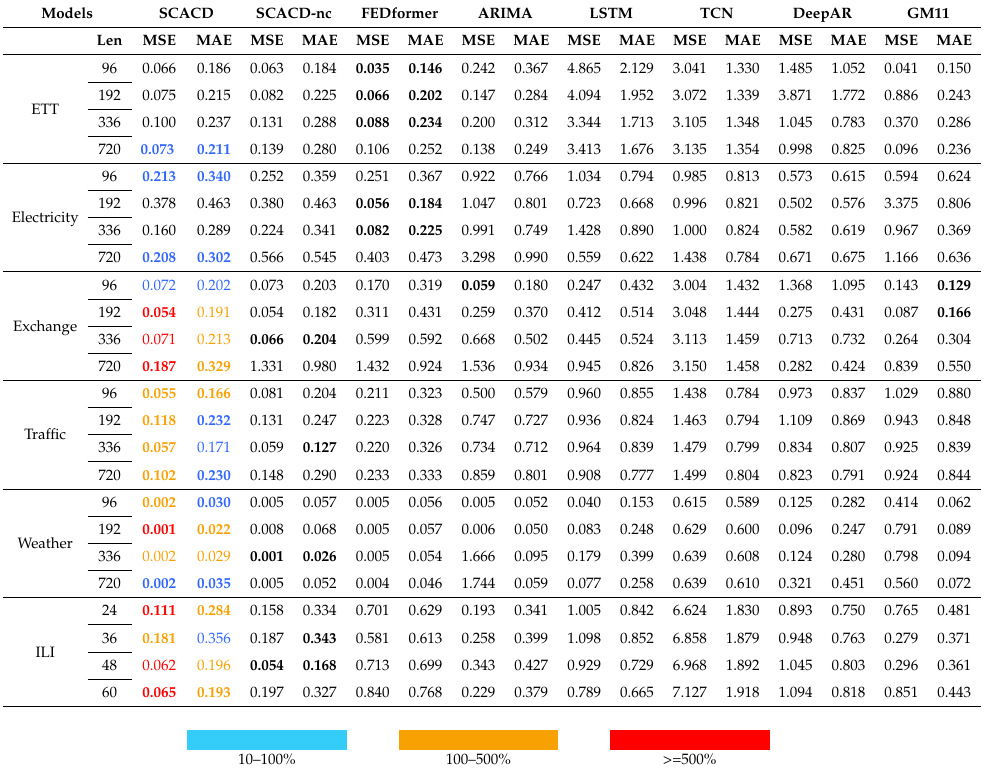
Table 2. The best results are shown in bold. Compared with the current state-of-the-art FEDformer, the experimental effect of SCACD is improved by 10–100% in blue font, 100–500% in brown font, and greater than 500% in red font. The results for TCN are from Autoformer